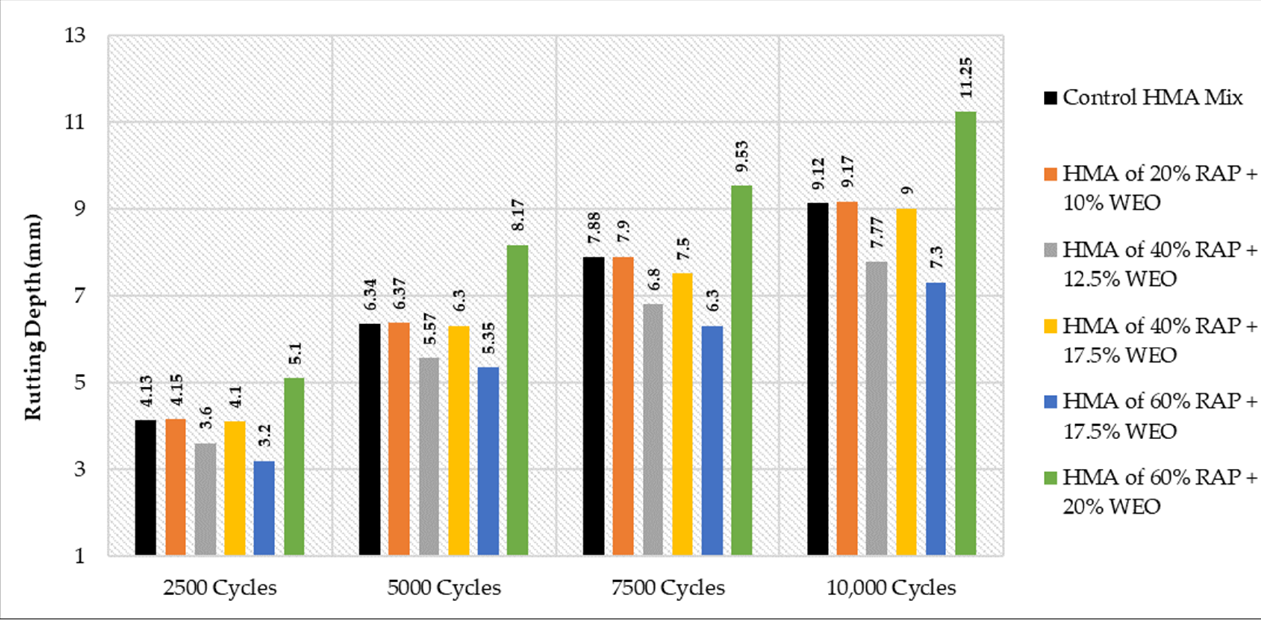
Figure 26. Rutting depths of recycled HMA mixtures rejuvenated by WEO.